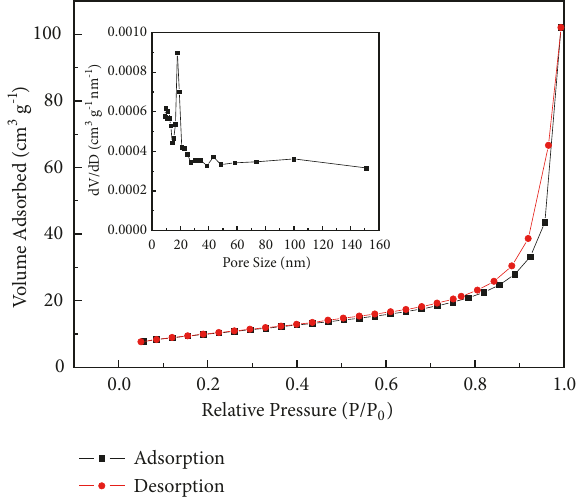
Figure 2: Nitrogen adsorption-desorption isotherms and pore size distribution of the FA-grafted